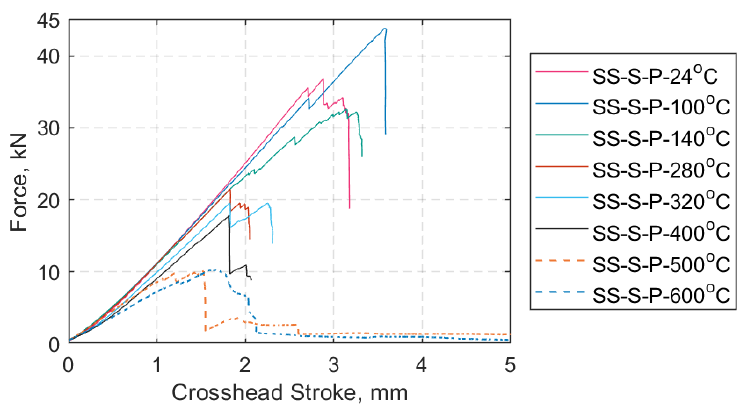
Figure 19. Force (kN) vs. crosshead stroke (mm) representative curves for each SS case. Calculation of the longitudinal elastic modulus followed the ISO 527-5 standard test method [40], i.e., the strain values used were 0.05% and 0.25% with the corresponding stress values, respectively. In all cases the strain values shown are those obtained using DIC. The data were processed in MATLAB 2019Rb. For the SS tests at 600 ◦ C, the